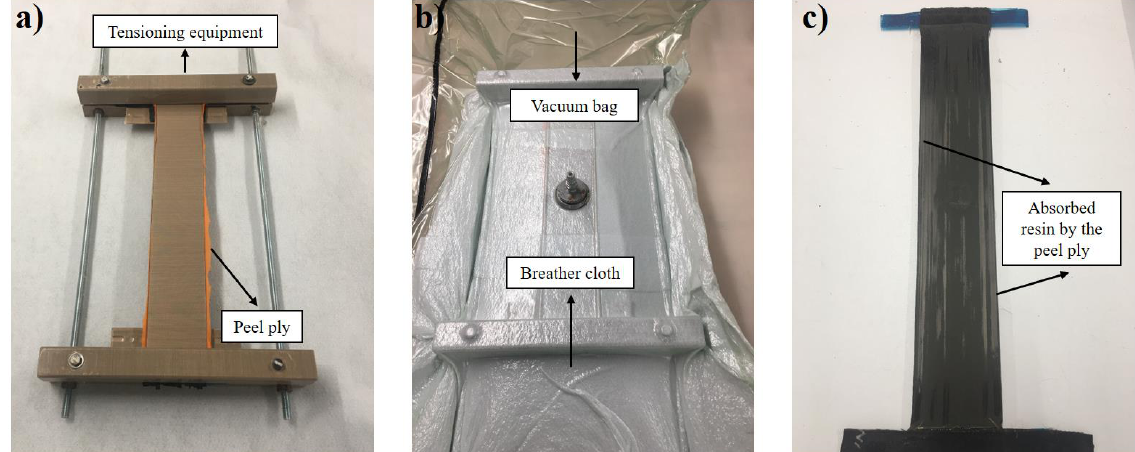
Table 1. FVF of the towpreg strips and composite plates at different processing parameters.